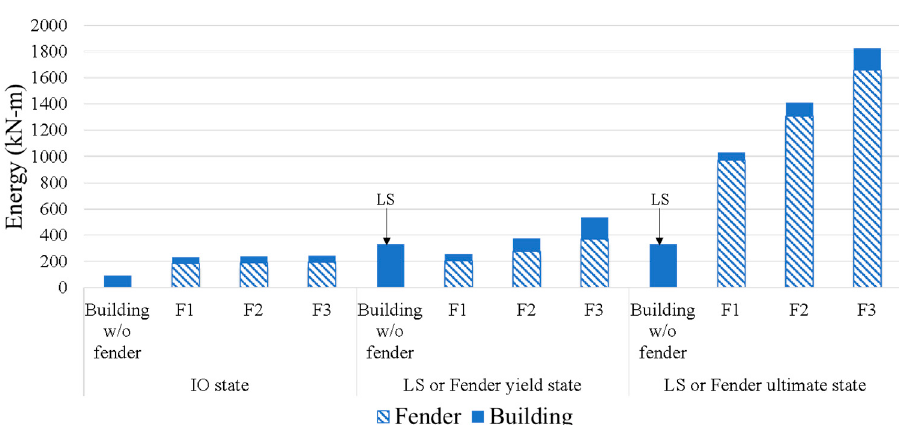
Figure 18. Energy absorption of the buildings with and without the fender structure.